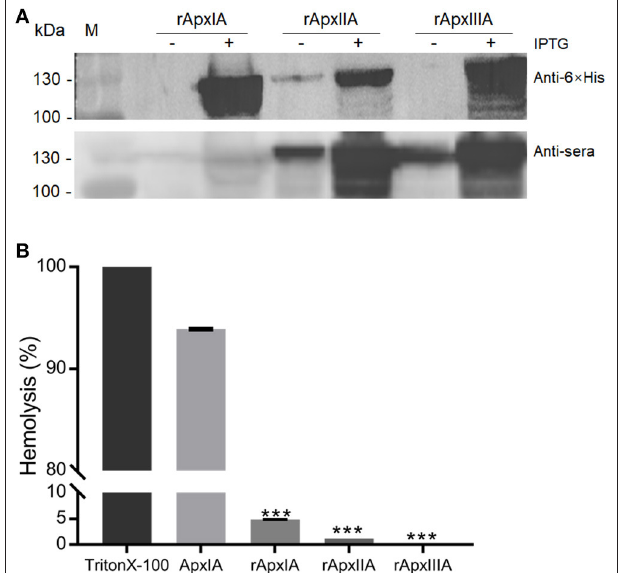
FIGURE 1 | Western blot analysis of the recombinant proteins ApxIA, ApxIIA, and ApxIIIA (A) using the 6 × His-Tag antibody (upper panel) and anti-sera of trivalent bacterin-vaccinated pigs (lower panel). Sheep RBCs were lysed with the three protoxins and native ApxIA diluted 2-fold from 125 µ g in the hemolytic assay, and 100% RBCs were lysed with Triton X-100 (B) . *** p < 0.005 (one-way ANOVA).